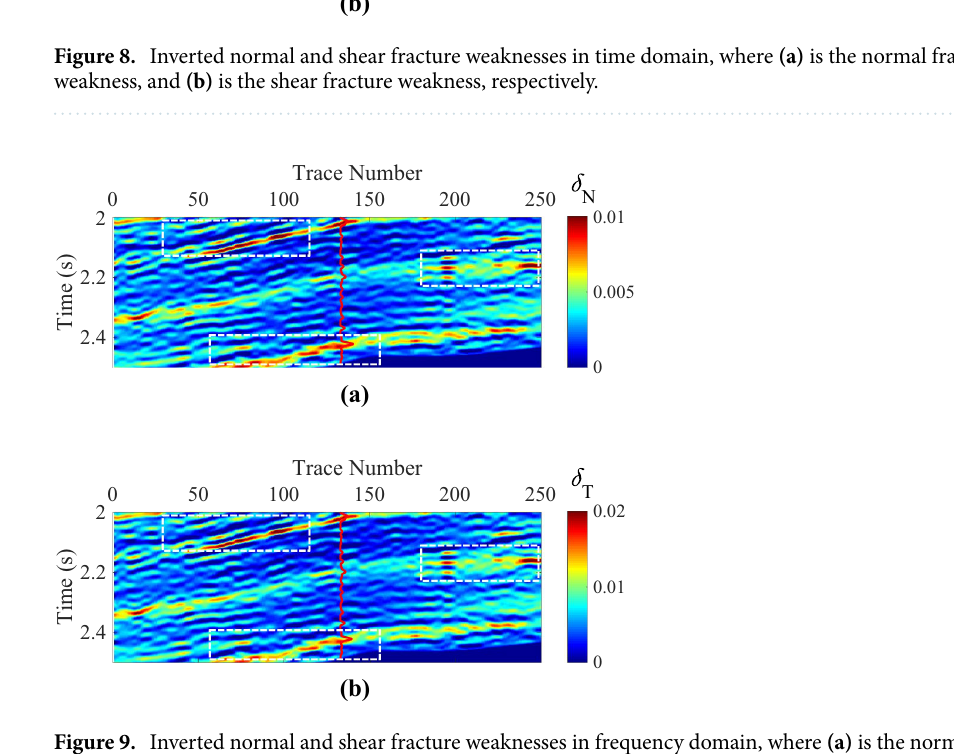
Figure 9. Inverted normal and shear fracture weaknesses in frequency domain, where (a) is the normal fracture weakness, and (b) is the shear fracture weakness,